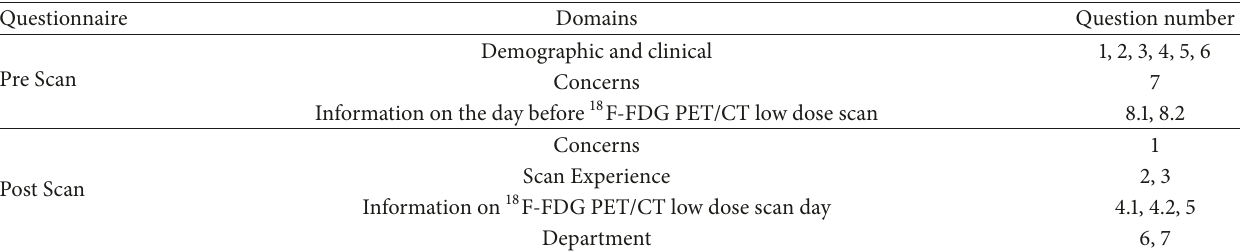
Table 1: Domains of the Scan Questionnaire Experience (SQE) questionnaires: before and after